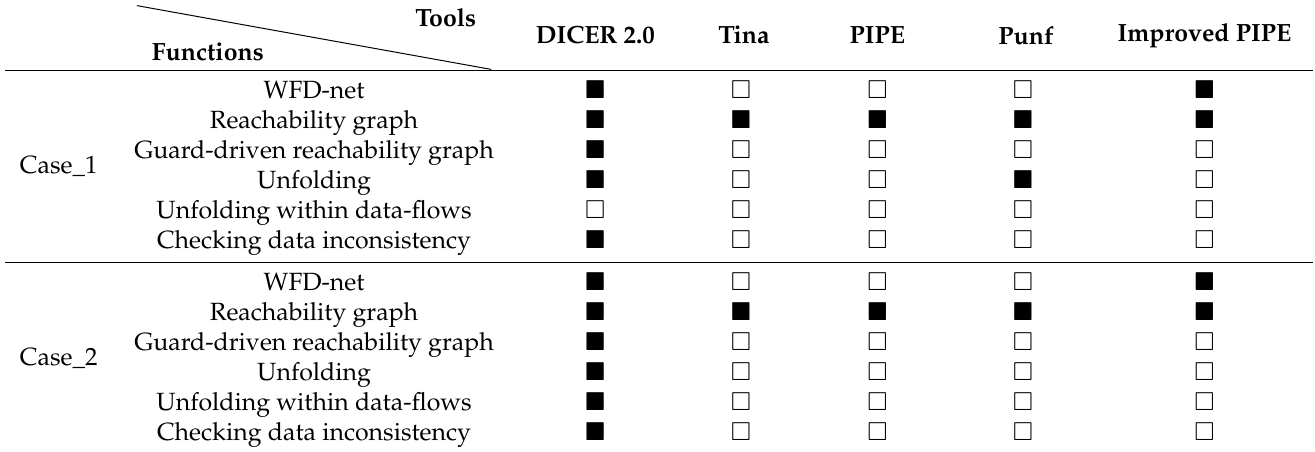
Table 7. The comparison experiments on the functions of DICER 2.0 and other Petri net tools. Tools DICER 2.0 Functions